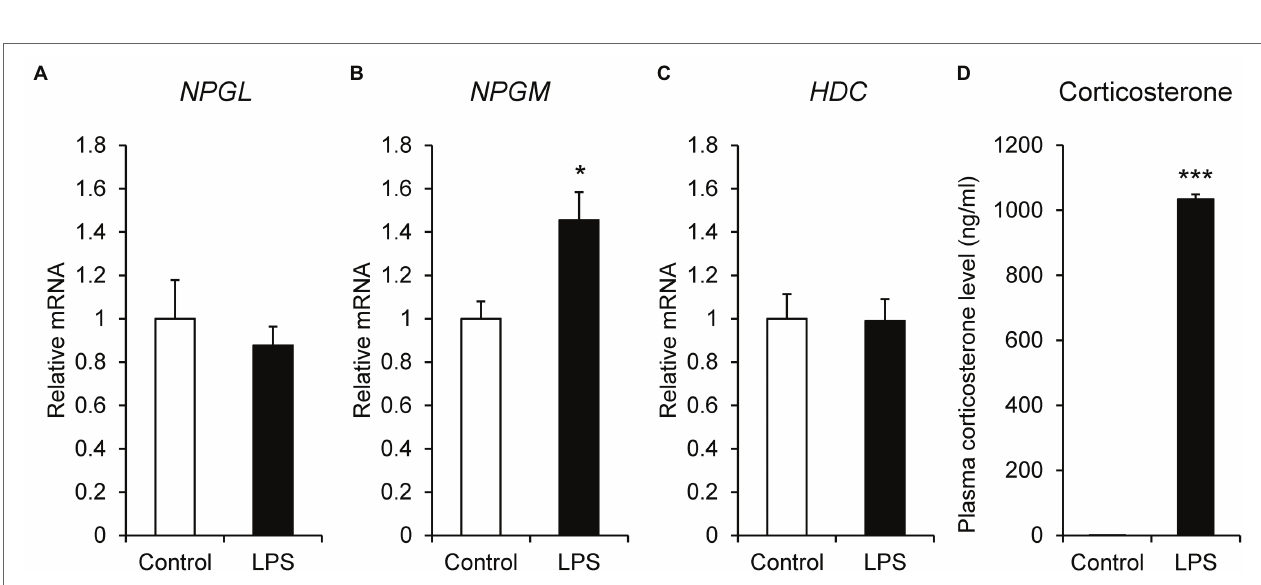
FIGURE 2 | mRNA expression levels, neurosecretory protein GL ( NPGL ; A ), neurosecretory protein GM ( NPGM ; B ), histidine decarboxylase ( HDC ; C ) in the mediobasal hypothalamus in the heat stress experiment at 37 ° C for 24 h. Plasma corticosterone concentration level (D) . Data are expressed as the mean ± SEM ( n = 6). Data were analyzed by Student’s t -test.